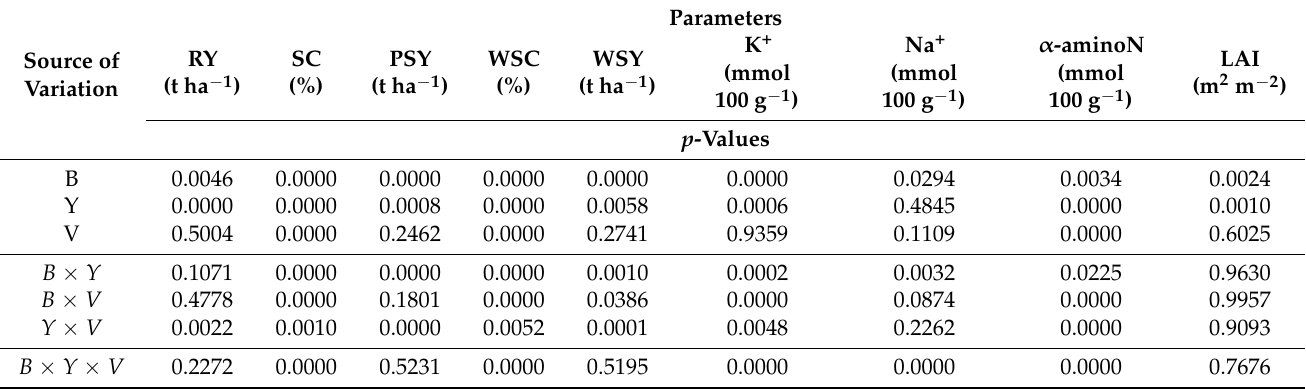
Table 1. Analysis of variance (ANOVA) in sugar beet experiment.